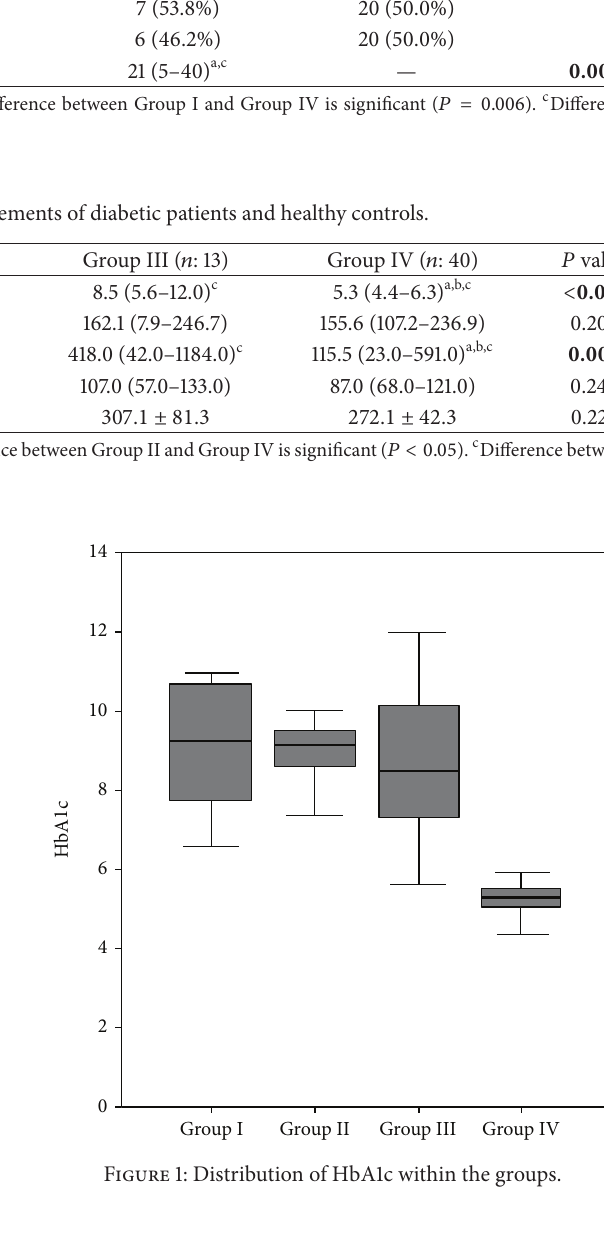
The median serum HbA1c levels were similar in the diabetic groups (group I, II, and III) and were increased significantly, compared with the control group, as expected ( 𝑃 < 0.001 ; Figure 1). Serum PAI-1 levels were higher in the diabetic groups than control, but this was not statistically significant ( 𝑃 = 0.209 ). The levels of serum fibrinogen ( 𝑃 = 0.224 ) and plasminogen ( 𝑃 = 0.244 ) were similar between the diabetic and control groups (Table